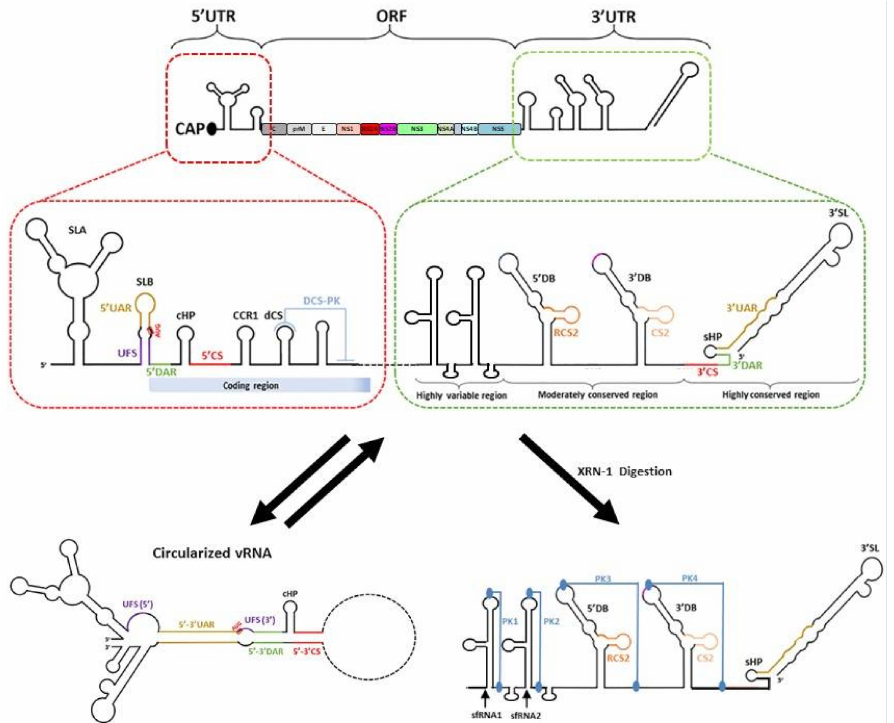
Figure 7. Schematic representation of the flavivirus genome. The figure is adapted from [145]. The viral genome is capped with a single open reading frame that is flanked by both 5 (cid:48) and 3 (cid:48) UTRs. Functional RNA elements in the 5 (cid:48) UTR include stem-loop (SL) A, SLB, the upstream AUG region (UAR), UAR-flanking stem (UFS) and the capsid-coding region hairpin (cHP). The 3 (cid:48) UTR can be classified into three regions based on sequence conservation and includes functional elements such as DB and 3 (cid:48) SL. These secondary structures and functional RNA elements are shown and annotated. The viral genome is also proposed to undergo genome cyclisation. The circularisation is mediated by sets of inverted complementary sequences 5 (cid:48) UAR-3 (cid:48) UAR, and 5 (cid:48) downstream AUG region (DAR)- 3 (cid:48) DAR, 5 (cid:48) cyclisation sequence (CS)-3 (cid:48) CS, as illustrated. The predicted subgenomic RNAs